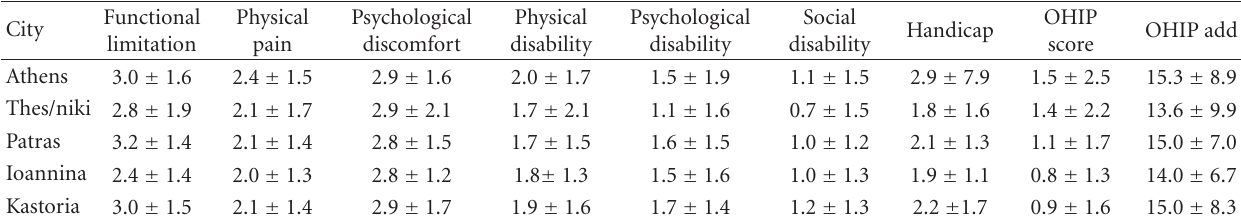
Table 1: Mean OHIP-14 for the subscales and total scores according to city.